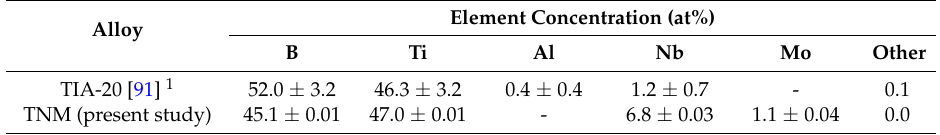
Table 1. Boride composition determined as reported in reference [91] and in the present work. The standard error is given next to each concentration. Both particles correspond to mono-borides in accordance with a MB stoichiometry, where M represents the constituting metal atoms.